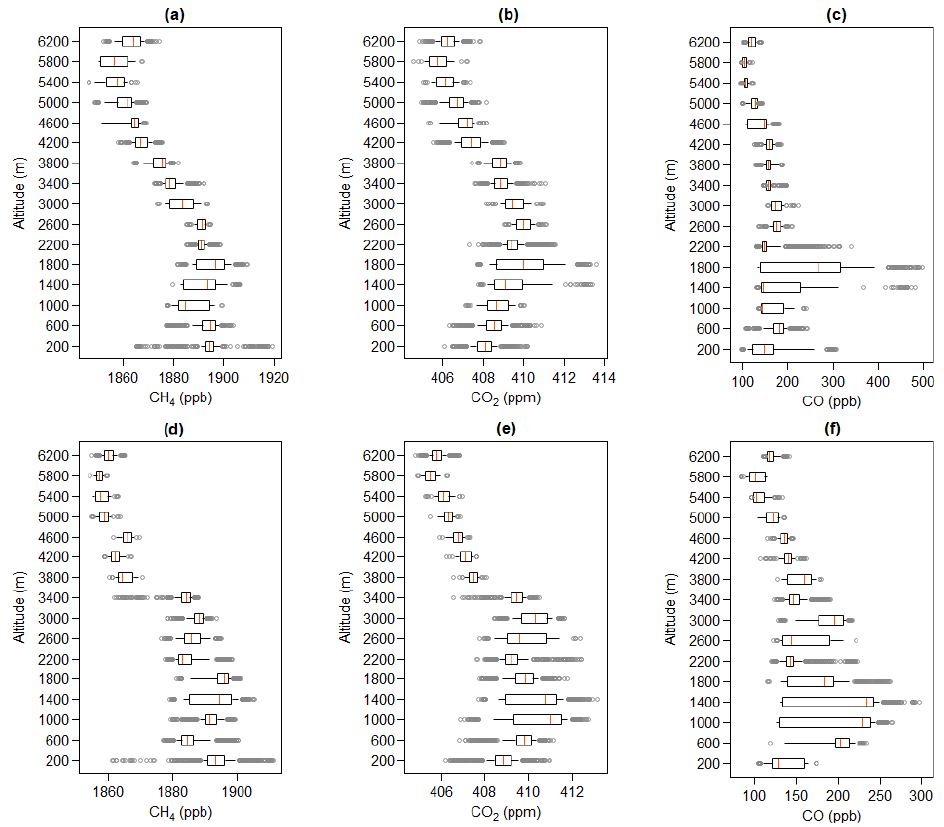
Figure 10. Box–whisker plots of (a) CH 4 , (b) CO 2 , and (c) CO altitude profiles for flight C006 and (d) CH 4 , (e) CO 2 , and (f) CO alti- tude profiles for flight C007. Altitude is divided into 400m vertical bins for all box–whisker plots. The boxes represent the 25th and 75th percentiles, whiskers represent 10th and 90th percentiles, and the grey circular points are